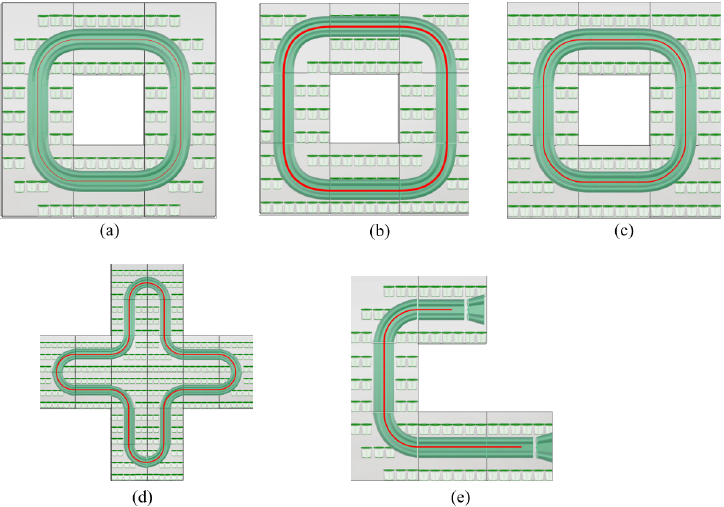
Figure 11. Vertical garden layouts created without attention to the introduced guidelines. The track height is 10 cm for all the cases other than ( a ). It should be noted that the figures are not in the same scale. ( a ): The track height is designed not according to the guidelines. Track height is 25 cm. ( b , c , e ): The pot placing is not according to the guidelines. ( d ): An open track